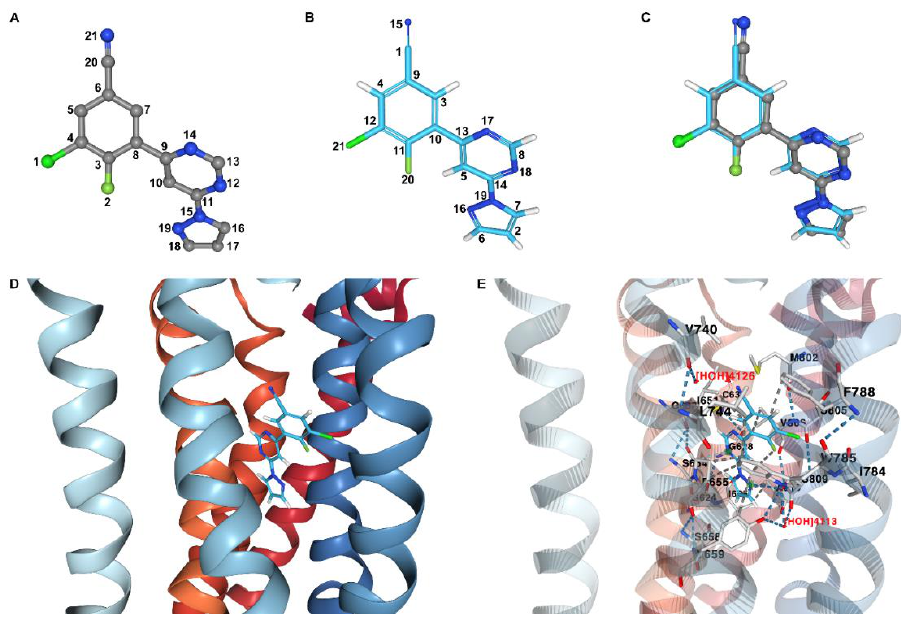
Figure 2. Analysis of re-docking results regarding a human class C GPCR receptor (mGlu5-StaR) with (3-chloro-4-fluoro-5-[6-(1H-pyrazol-1-yl)pyrimidin-4-yl]benzonitrile) — a negative allosteric modulator — bound in the allosteric site. Experimental pose of the ligand in ball and stick representation, with carbon, nitrogen, chlorine, and fluorine atoms coloured grey, blue, vivid green, and soft green, respectively. Docked pose of the ligand in liquorice representation, with carbon, nitrogen, chlorine, fluorine, and hydrogen atoms coloured light blue, blue, vivid green, soft green, and white, respectively. Receptor in cartoon representation, with atom index colour style. ( A ) Atom indexes of the experimental pose of the ligand. ( B ) Atom indexes of the docked pose of the ligand assigned by OpenEye HYBRID docking program. ( C ) Ligand docked pose superimposed onto the ligand experimental pose. ( D ) Ligand docked pose within the receptor allosteric site. ( E ) Interactions between the receptor and the ligand in the docked pose within the allosteric site. Selected residues from the receptor are in liquorice representation, with carbon, oxygen, nitrogen, and sulphur atoms coloured light grey, red, blue, and yellow, respectively. These residues are labelled in black, and selected interactions are shown as dashed lines. Water molecules are coloured and labelled in red. The ligand atoms involved in the main interactions are surrounded by a green sphere. The receptor cartoon representation has been opacified for clarity.